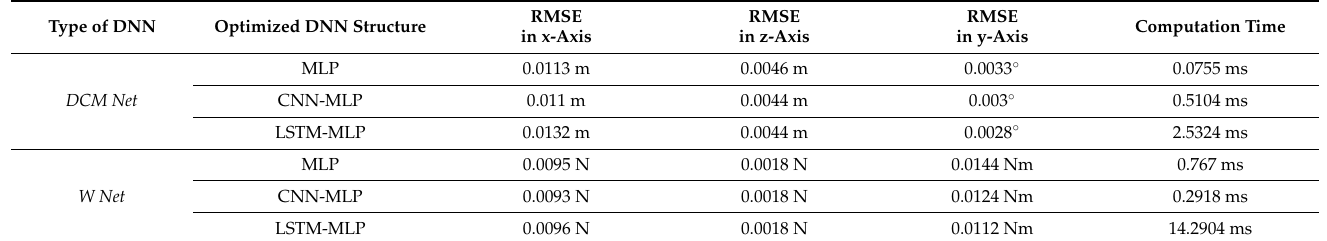
Table 3. Performance of Three Optimized DNN Structures for DCM Net and W Net of the actual